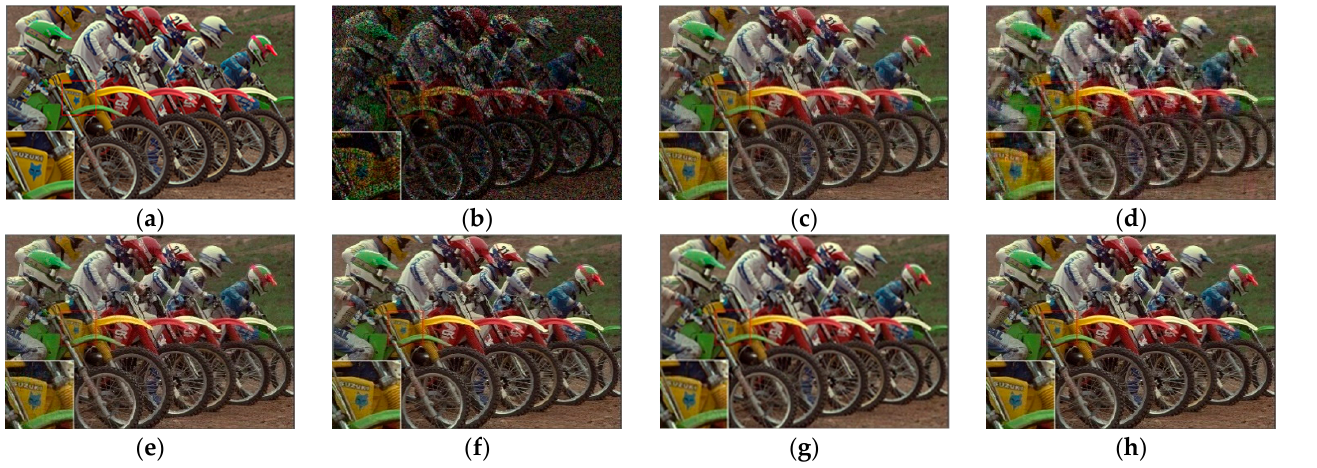
Figure 7. Visual effect comparison of different methods on the color image kodim05. The incomplete image contains 50% missing entries, shown as black pixels. ( a ) Original image; ( b ) Incomplete image; ( c ) FaLRTC (26.01 dB); ( d ) TCTF (22.45 dB); ( e )LRTC-TNN1 (28.34 dB); ( f ) LRTC-TNN2 (29.98 dB);